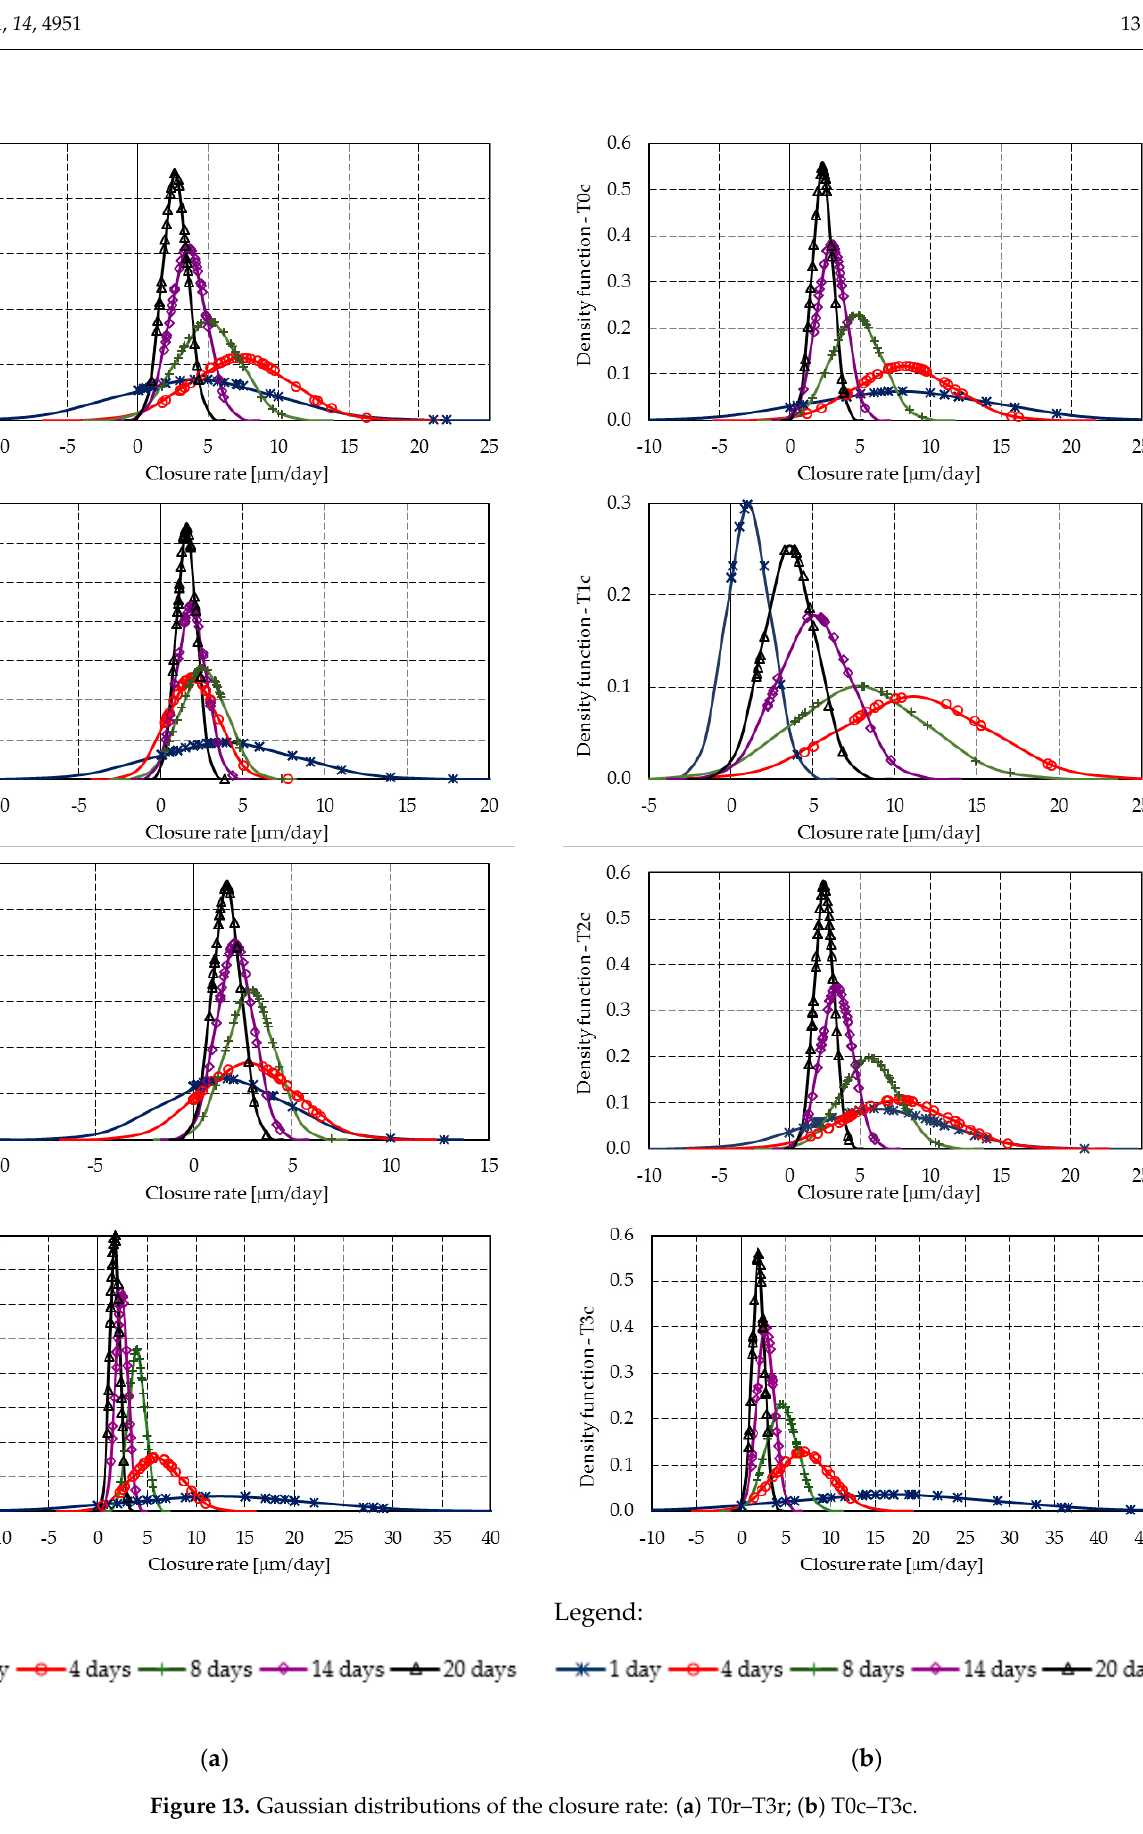
Figure 13. Gaussian distributions of the closure rate: ( a ) T0r–T3r; ( b ) T0c–T3c.